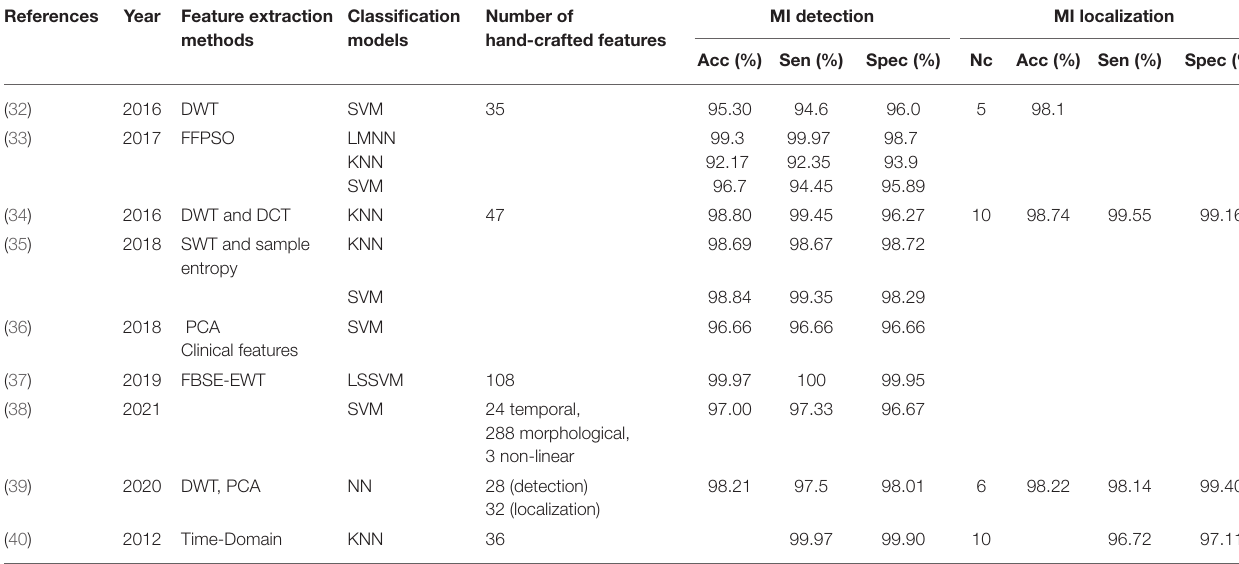
TABLE 2 | Recent conventional machine learning methods for MI detection and